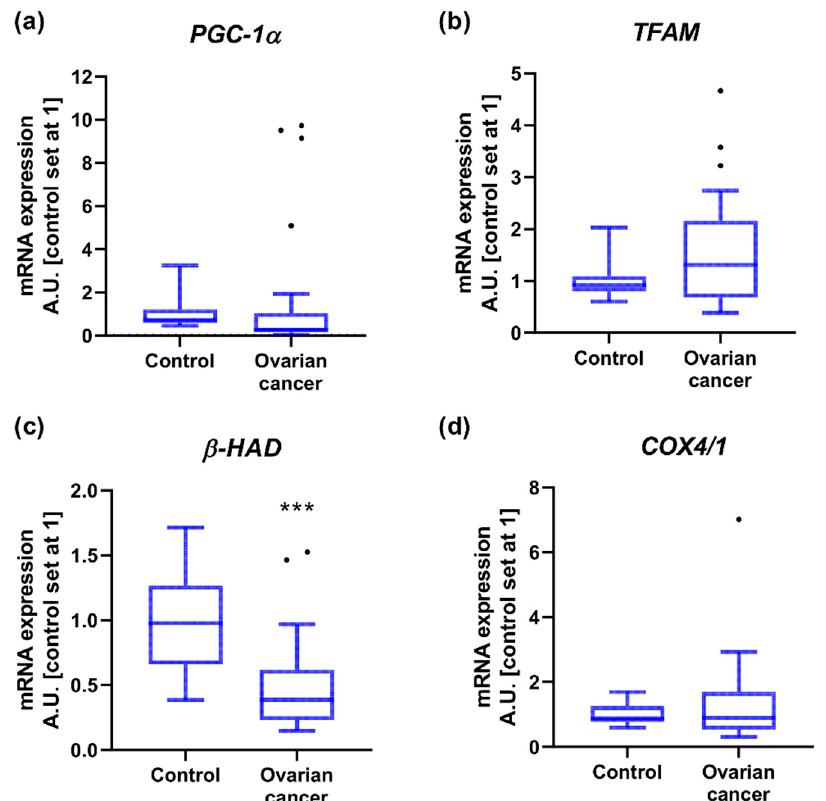
Figure 2. Transcript levels of ( a ) peroxisome proliferator-activated receptor gamma co-activator 1 α , ( b ) mitochondrial transcription factor A, ( c ) acetyl-CoA acyltransferase and ( d ) cytochrome c oxidase subunit 4 isoform 1 in ovarian control (n = 14) and cancer tissue (n = 27). Measurements were made in duplicate and arithmetic means were used for subsequent investigation. Results are expressed in arbitrary units with control set as 1 and presented as median (min to max) value. Differences statistically significant at *** p < 0.001.